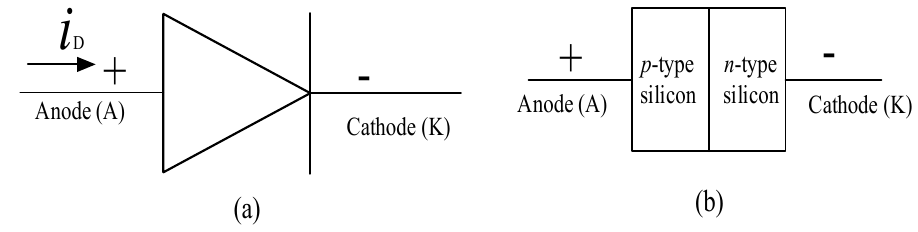
Figure 3. ( a ) Schematic symbol and ( b ) basic structure of a diode [91].